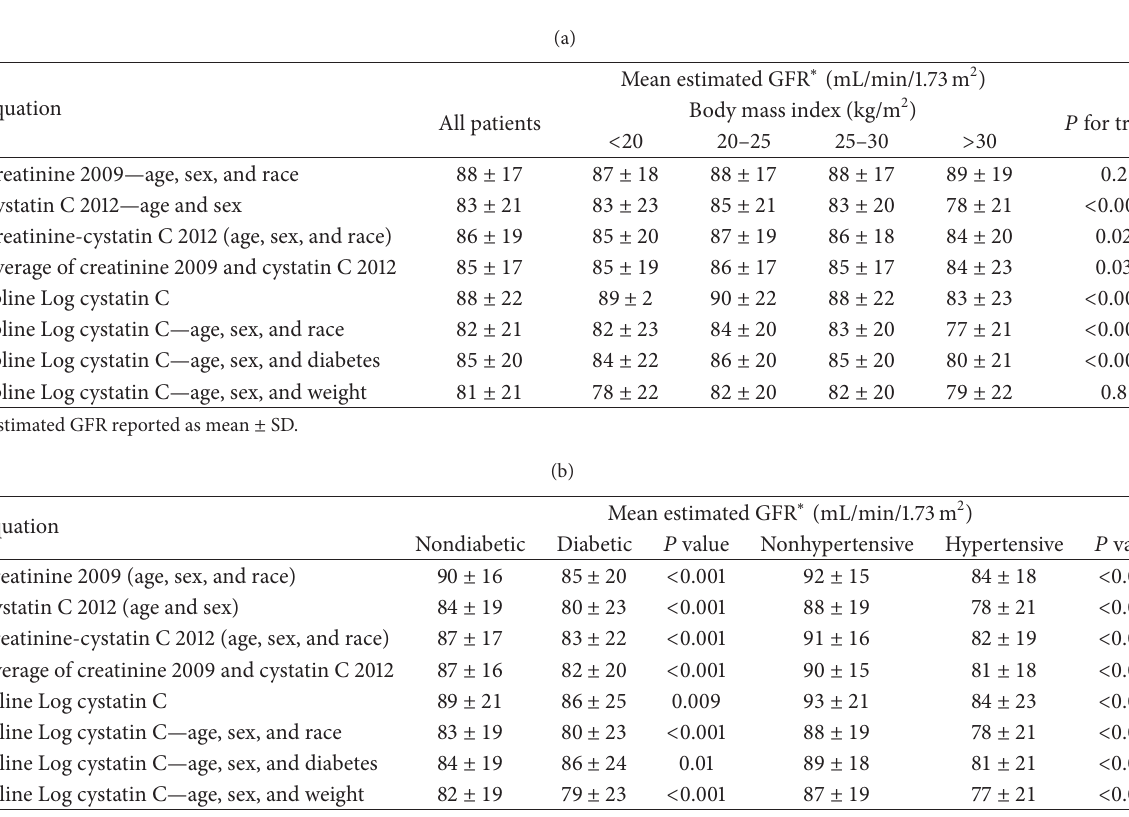
Table 2: (a) Distribution of mean estimated GFR by BMI categories. (b) Distribution of mean estimated GFR by disease subgroups.